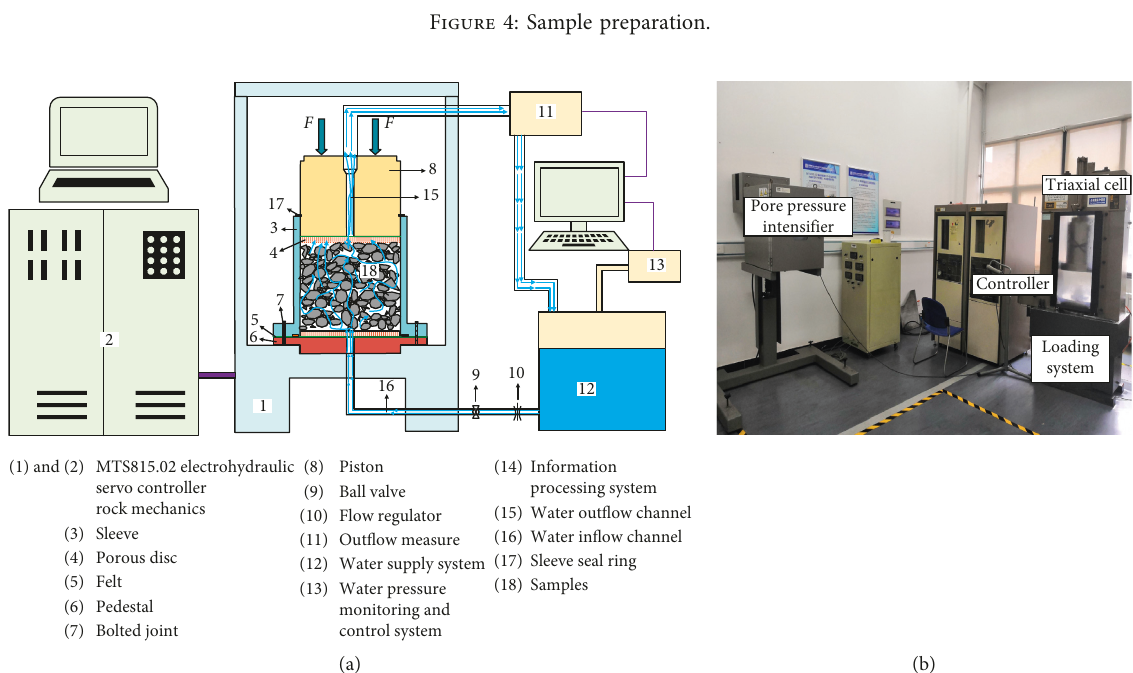
Figure 5: Testing system of the seepage evolution